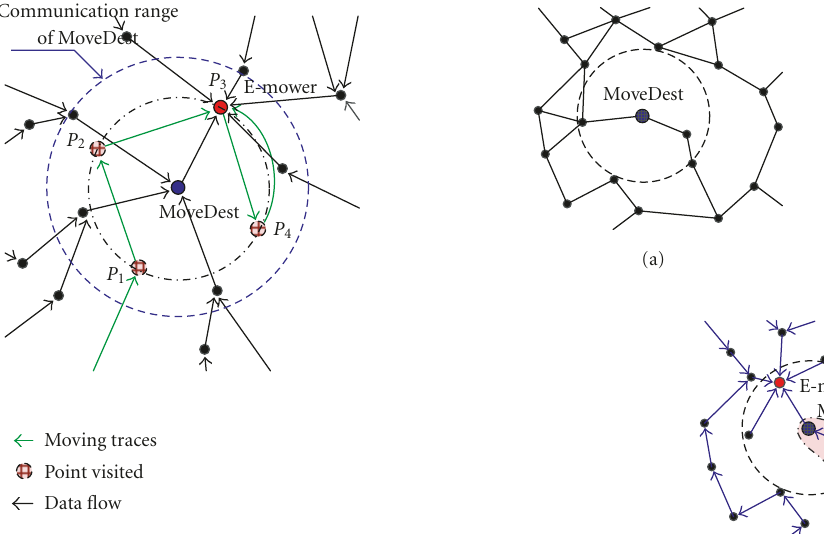
Figure 4: An example of that the energy mower employs the square hopping mechanism to choose a proper sojourn position around MoveDest.